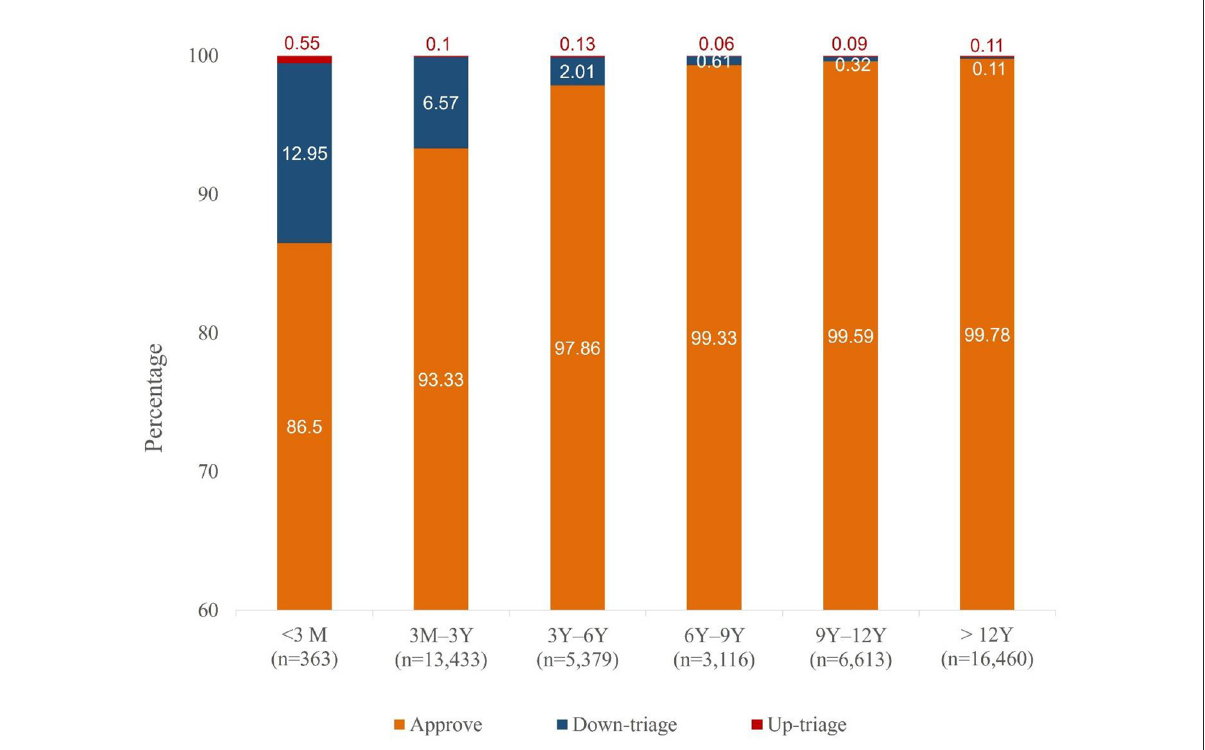
FIGURE3 The proportion of nurse-modified group by age. M, months; Y,